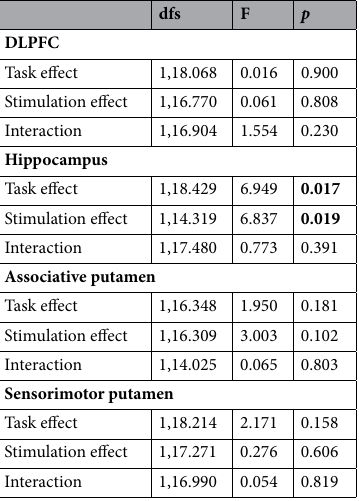
Table 2. Task by stimulation effects on pattern similarity between RS pre- and post-stimulation/task controlling for the visit effect. Bold values indicate p < 0.05. None of the results presented in this table survived FDR correction for 4 ROIs. DLPFC - dorsolateral prefrontal cortex, dfs - degrees of